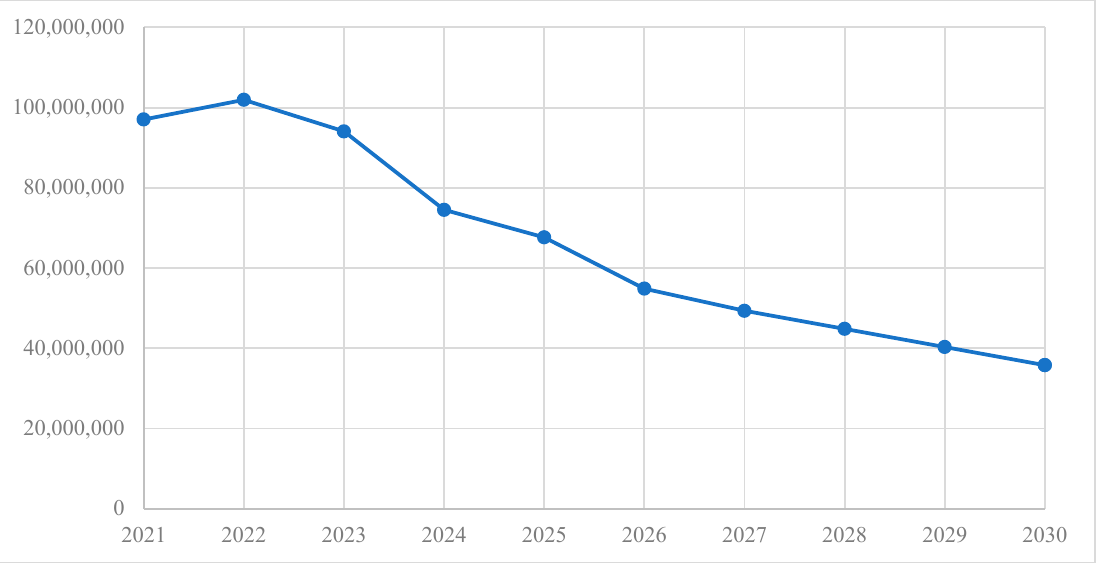
Figure 2. CO 2 Emissions between 2021–2030 (tons).